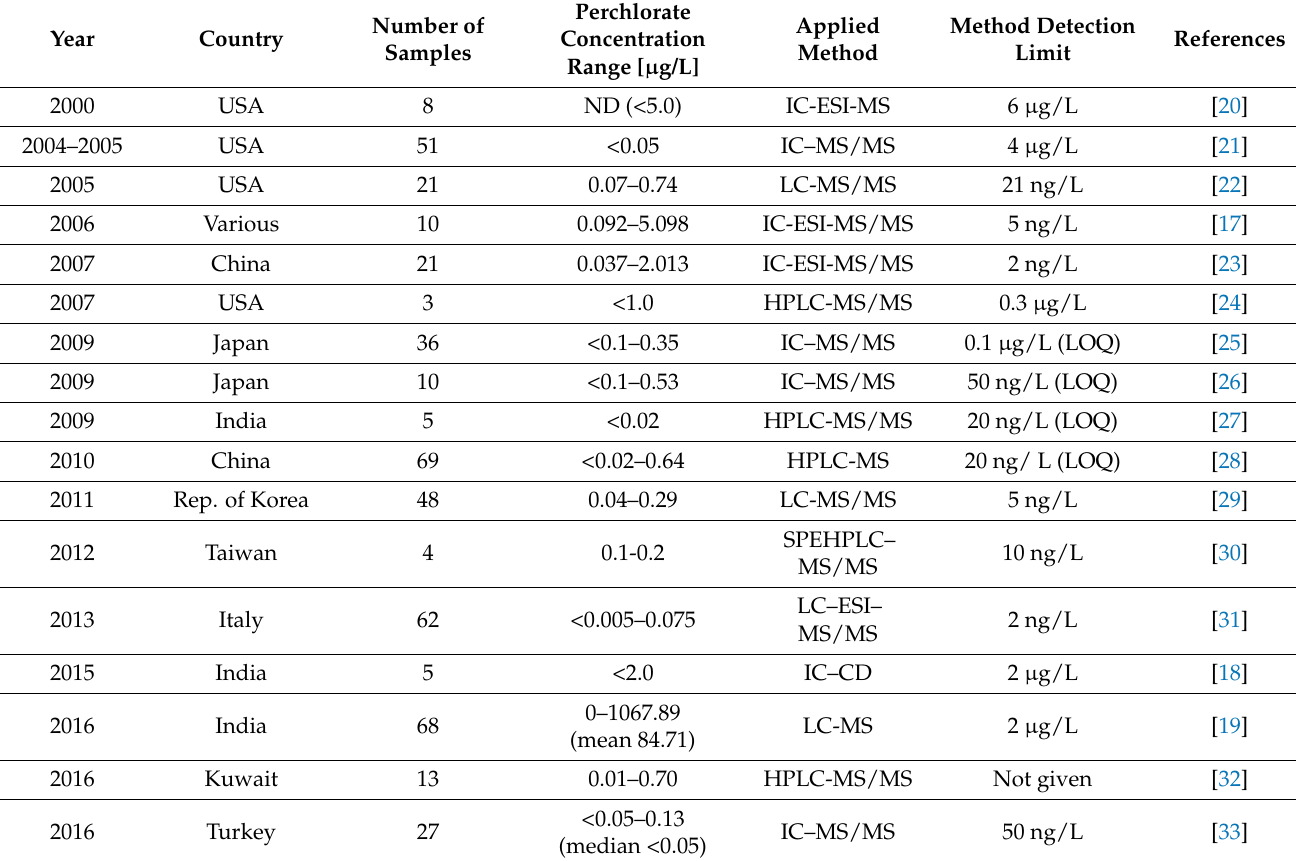
Table 2. Occurrence of perchlorate in bottled water in various geographical